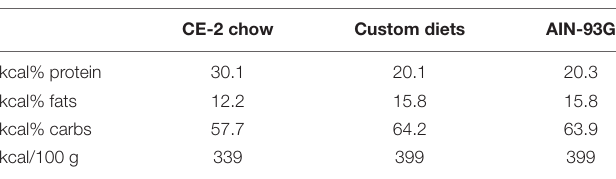
TABLE 4 | Nutrition of